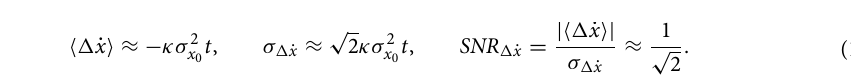
As noticeable from Fig.3c,d, the mean instantaneous velocity of Eq. (12) holds true only for values of initial 0.5 (blue dots). However, for particles initially moving at higher speed (green and red dots), x 0 velocities �˙ � = ± the approximation in Eq. (12) fails to describe the motion now modified by higher order nonlinear terms, as the can only be investigated by numerical stochastic simulations. The SNR affected by the change in initial velocity (green and red dots), for larger σ 2 x 1 / √ 2 of Eq. (12). SNR x = ˙ To visualise the effect of initial velocity